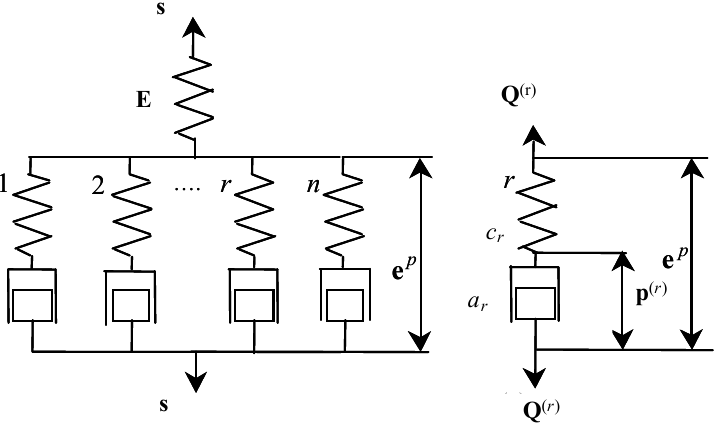
Figure 1. Mechanical model for the contribution of